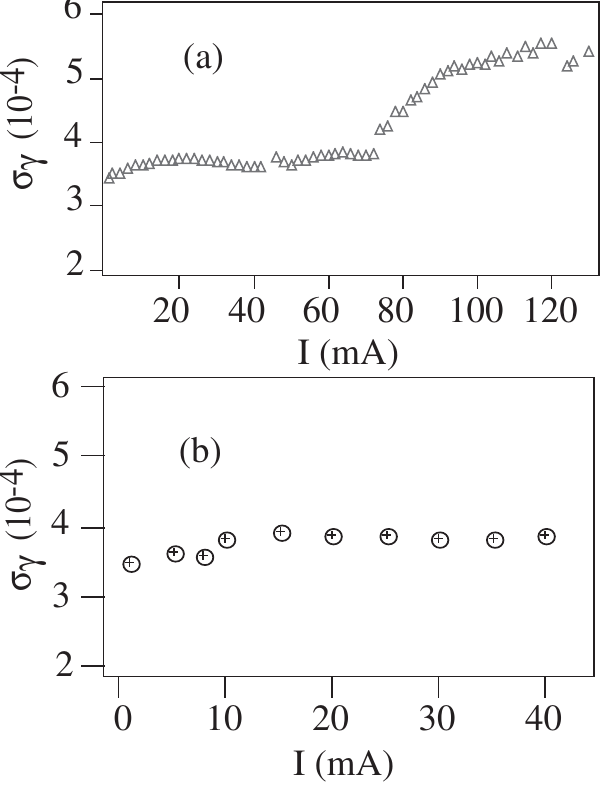
FIG. 4. Energy spread versus current from the optical klystron method: (a) in the chromatic case (for I (cid:6) 0 to 120 mA), (b) in the achromatic case (for I (cid:6) 0 to 40